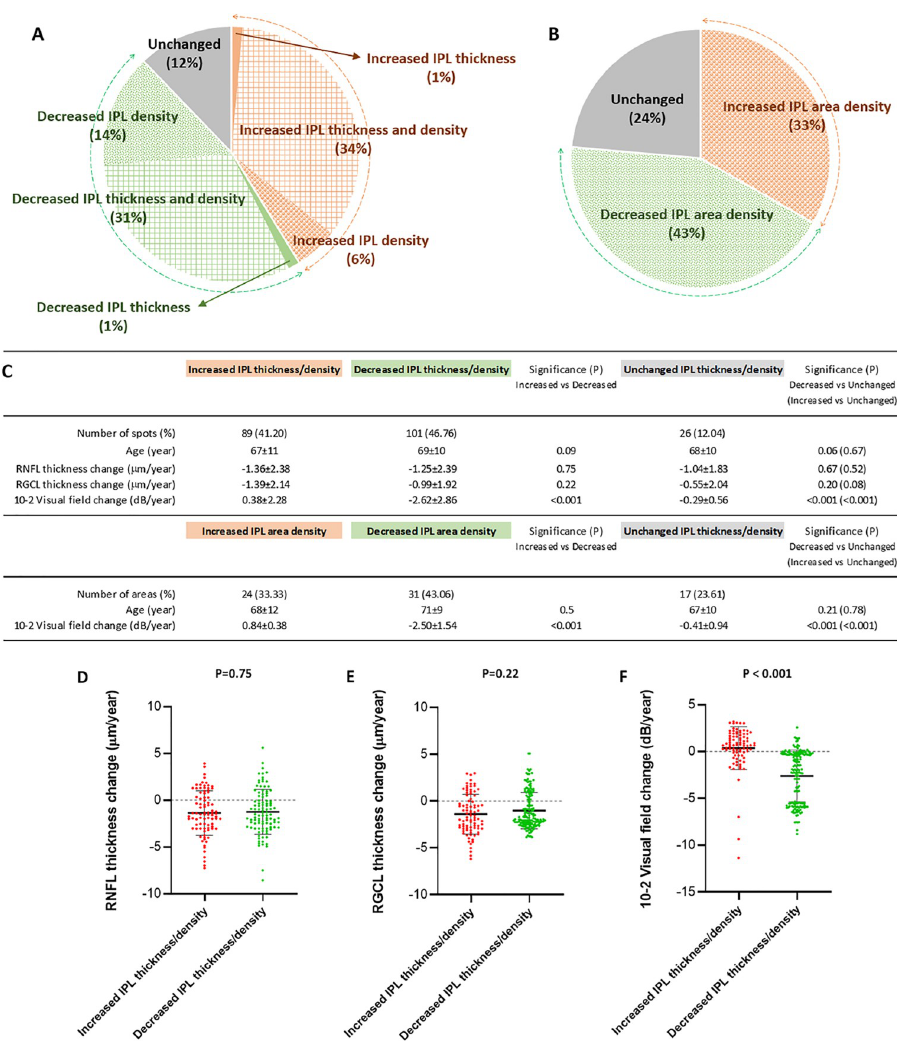
Fig 4. Distribution and associations of IPL alterations in patients with glaucoma. The pie graphs in panels A and B show the distribution of analysis locations with or without alterations in IPL imaging parameters over the two-year follow-up. These IPL alterations reflect those beyond the 95% confidence intervals of the change that was estimated by GEE. As shown in panel A , both the IPL thickness and the linear density increased at 74 (34%; red box-patterned area) analysis locations out of 216; while only the IPL thickness increased at 3 (1%; red area) or only the IPL density increased at 12 (6%; red dotted area) analysis locations. In contrast, at 67 analysis locations (31%; green box-patterned area), both the IPL thickness and the linear density decreased, while only the IPL thickness decreased at 3 (1%; green area) or only the IPL density decreased at 31 (14%; green dotted area) analysis locations. In 26 analysis locations (12%; gray area), the IPL thickness or density did not change significantly. As shown in panel B, the area density of the IPL (analyzed within 2 mm from the center of the macula on nasal and temporal sides) increased at 24 (33%; red area), decreased at 31 (43%, green area), or unchanged at 17 (24%; gray area) out of 72 analysis locations. Accompanying table (C) presents the RNFL thickness, RGCL thickness, and 10–2 visual field total deviation scores (mean ± SD) for the analysis locations exhibiting increased (41%), decreased (47%), or unchanged (12%) IPL thickness and/or density, as shown in panel A. Vertical scatterplots show data distribution for RNFL thickness ( D ), RGCL thickness ( E ), and 10–2 visual field total deviation ( F ) in the subgroups with IPL alterations in different